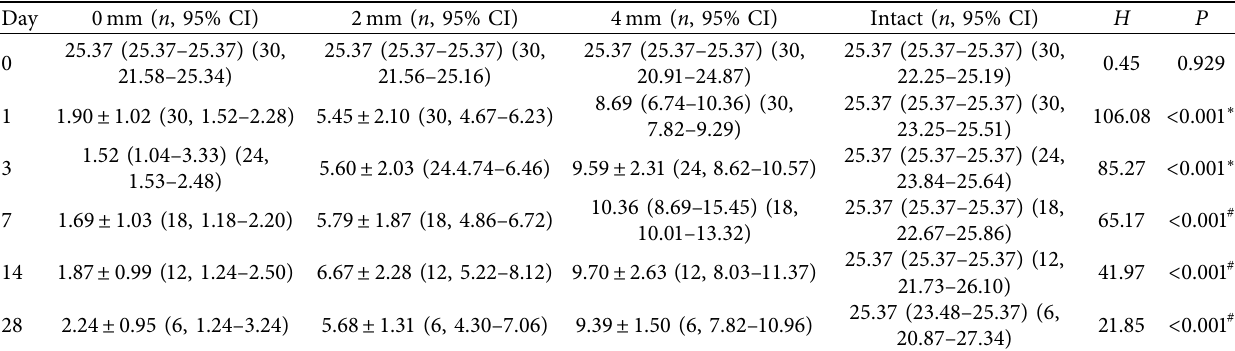
Figure 5: Immunohistochemistry in the C7 dorsal horn of the affected side in the control and MCAO groups. (a) Ionized calcium-binding Table 2: Changes in mechanical paw withdrawal threshold (mN) in the C7 neurotomy subgroups.